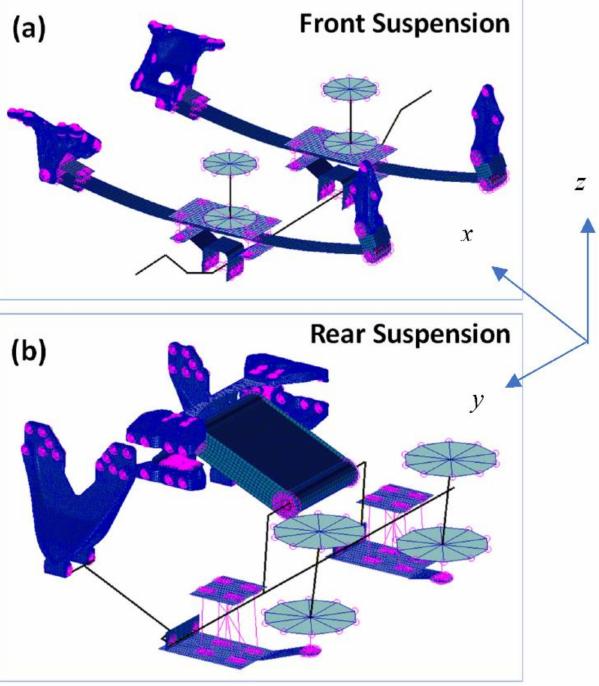
Figure 8. Finite element model showing the ( a ) front and ( b ) rear suspensions.